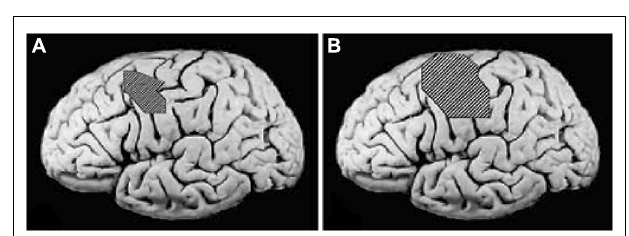
FIGURE 5 | (A) Pretreatment cortical map of the excitable area for the contralateral abductor pollicis brevis in a group of stroke patients determined by transcranial magnetic stimulation (TMS), superimposed on an unlesioned post mortem brain to indicate approximate size and location. (B) Post-treatmentTMS map in the same group of patients. Reprinted from Mark etal.